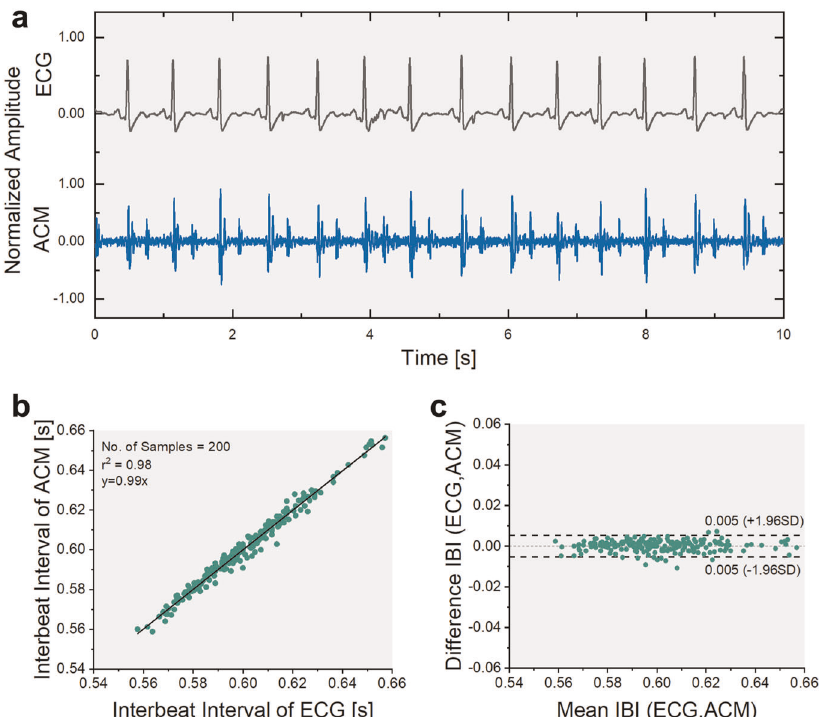
Fig. 3 Comparison and computation of diagnostic parameters. a Time domain plot of measured ECG signal alongside the ACM. b Correlation plot illustrating linear curve fi t with r 2 = 0.98 con fi rming effective use of ACM for computation of diagnostic parameters. c Bland- Altman plot comparing the technologies demonstrates 95% con fi dence interval having a range of 0.01 s.